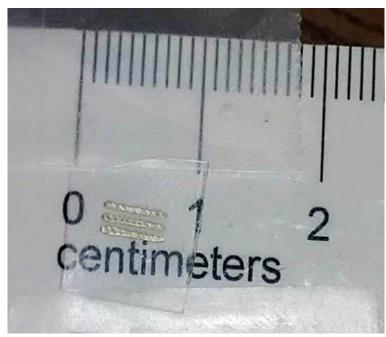
Figure 3. Simple straight-line pattern of silver after inkjet printing and plasma treatment.